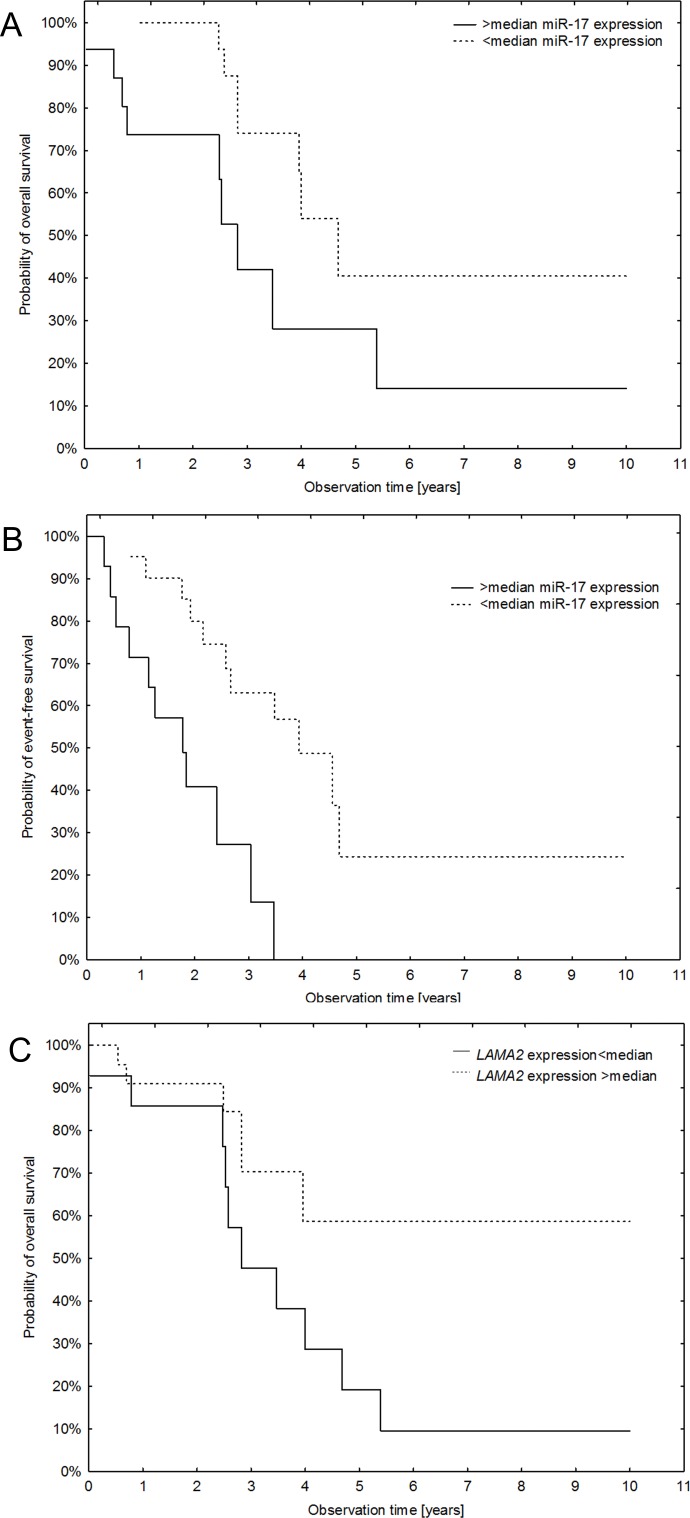
Survival analysis of patients with ependymoma.(A) Kaplan-Meier curves of overall survival depending on miR-17-5p expression dichotomized using median expression levels, p = 0.036. The probability of death was significantly higher in samples with higher expression of miR-17-5p. (B) Differences in event-free survival between samples with high and low expression of miR-17-5p, p = 0.002. The probability of death was significantly higher in samples with higher expression of miR-17-5p. (C) Differences in overall survival between samples with high and low expression of LAMA2, p = 0.069. The probability of death was higher in samples with lower expression of LAMA2.